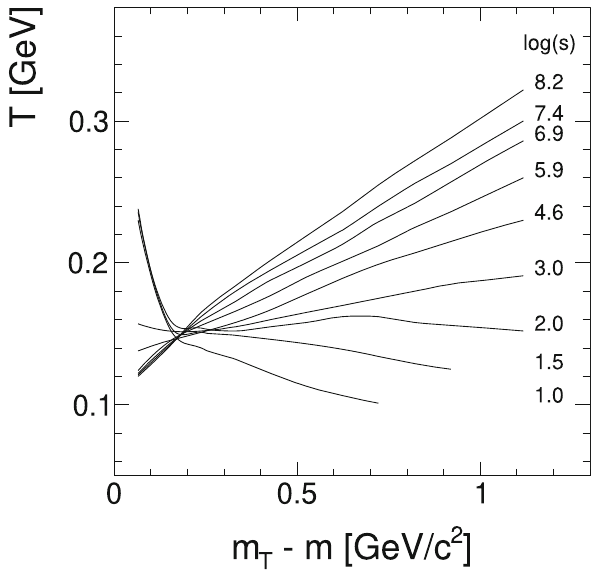
Fig. 141 Inverse slopes of the transverse mass distributions as a func- tion of m T − m for π − from log ( s ) = 1.0 to 8.0